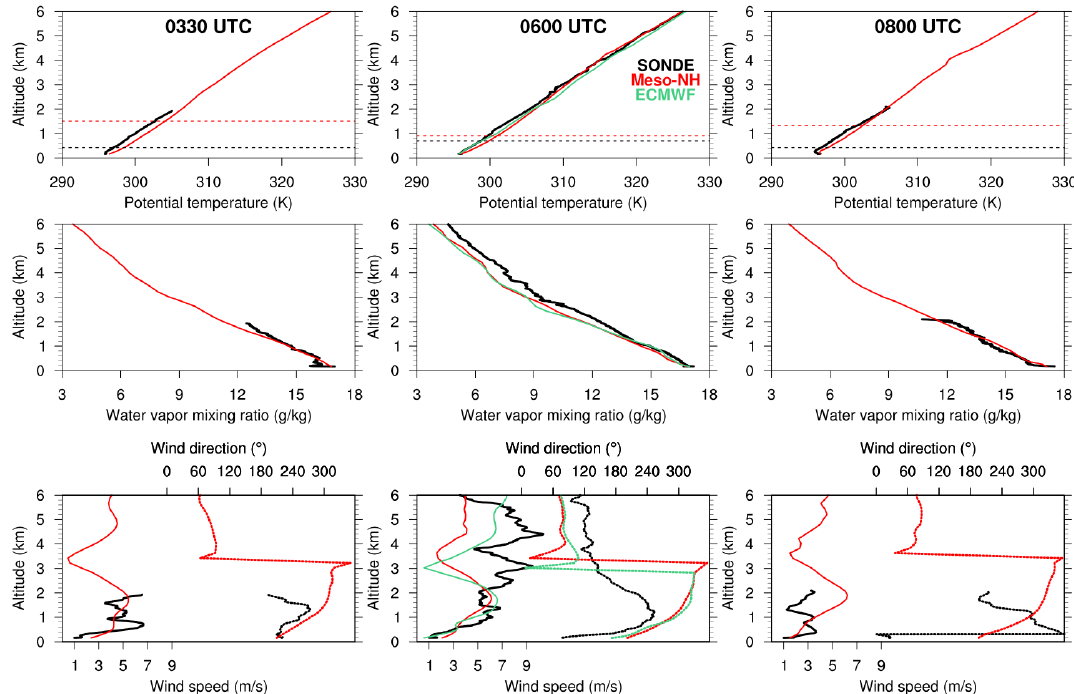
Figure 11. Vertical profiles of, from top to bottom, potential temperature, water vapor mixing ratio, wind speed and direction on 24 July 2016 at 03:30 ( left ), 06:00 (centre) and 08:00 UTC ( right ), for the soundings at Savè, the Meso-NH LES and the ECMWF operational analysis (the latter only at 06:00 UTC). For the simulation and the ECMWF analysis the profiles are taken at the nearest gridpoint to the Savè location. The horizontal dashed lines in the top panels represent the height of the lifting condensation level